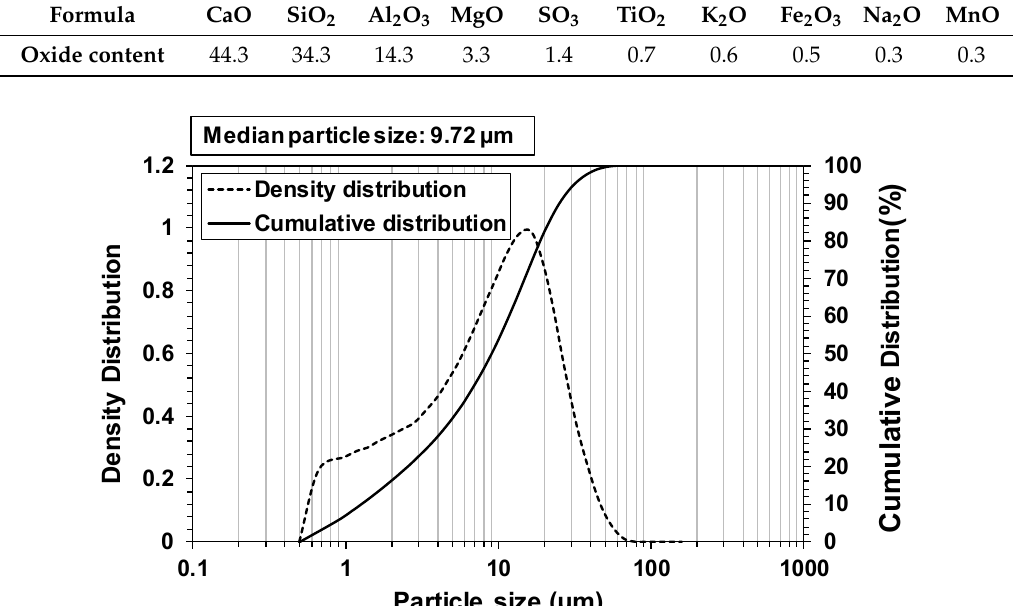
Table 1. Chemical composition of ground-granulated blast furnace slag (GGBFS) (wt %).